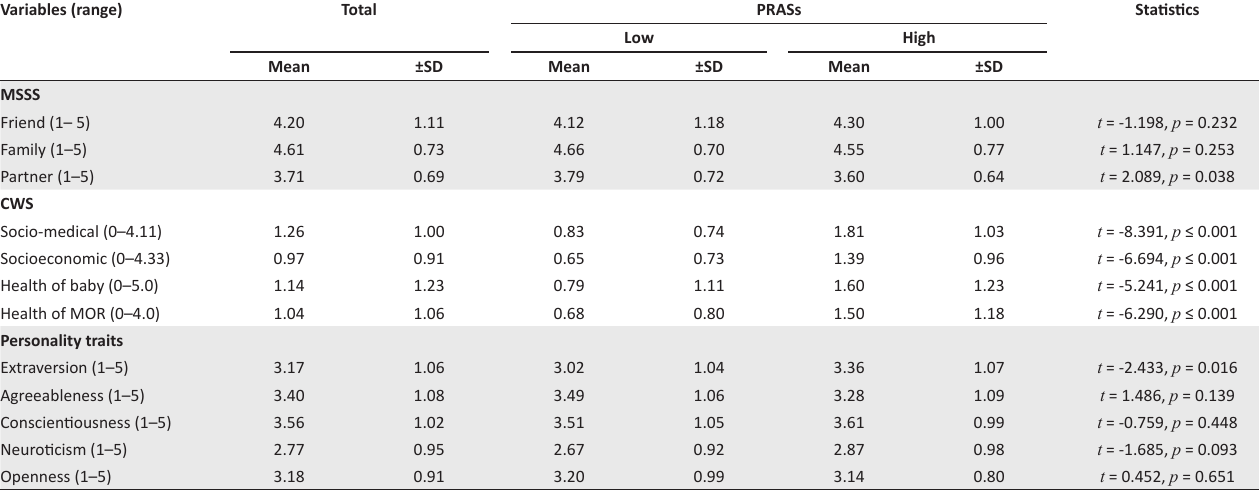
TABLE 4: Comparison of mean scores of psychosocial variables between respondents with low and high pregnancy-related anxiety symptoms. Variables